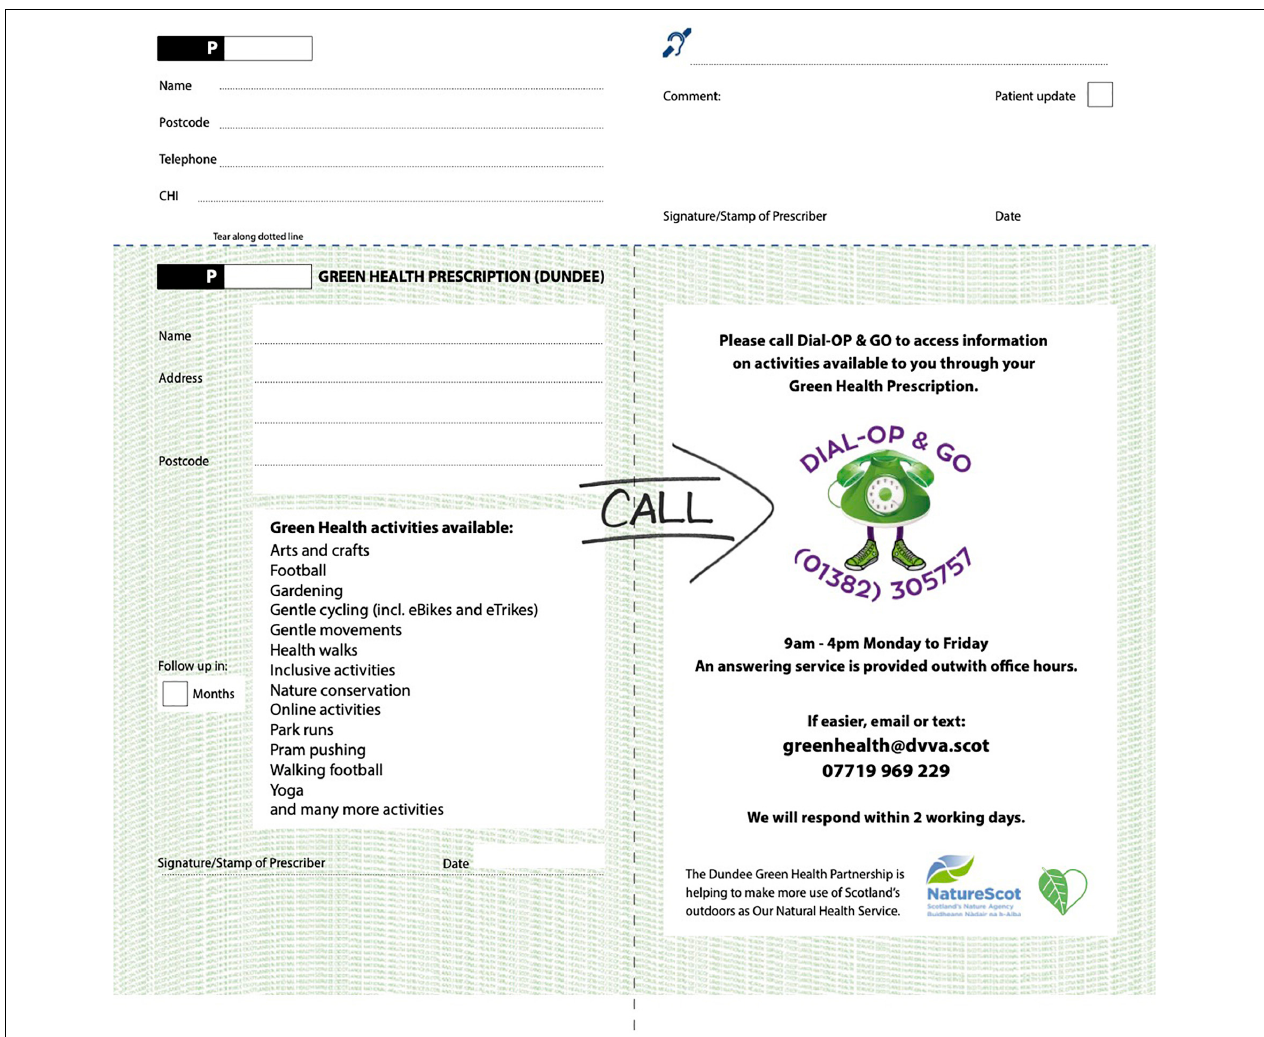
FIGURE 1 | Green Health Prescription front side. © Copyright of Green Health